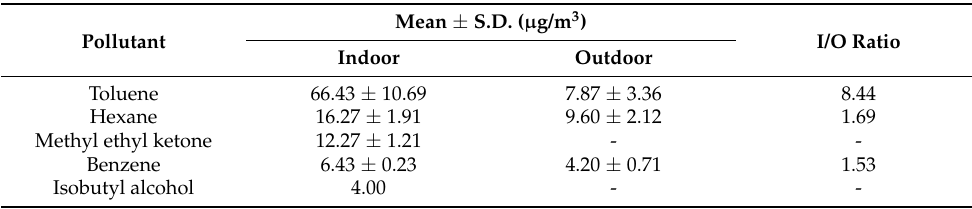
Table 5. Volatile organic compounds (VOCs) concentrations in the valuable archive. I/O ratio— indoor/outdoor ratio.